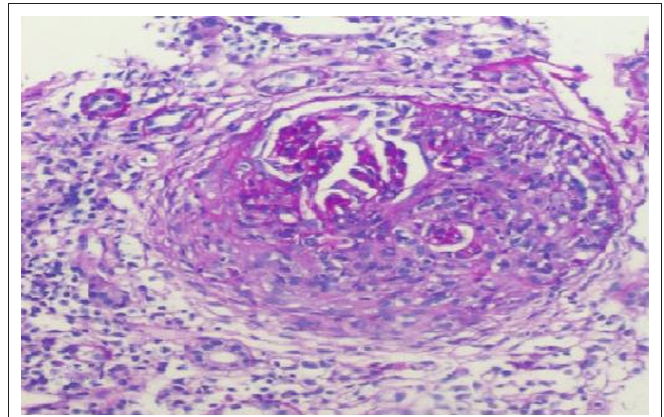
Figure 3. High magnification shows 1 glomeruli with complete cellular crescent, compression of glomerular tuft, and breakage of Bowman capsule with sunburst appearance (PAS stain, magnification 40 × ). PAS, periodic